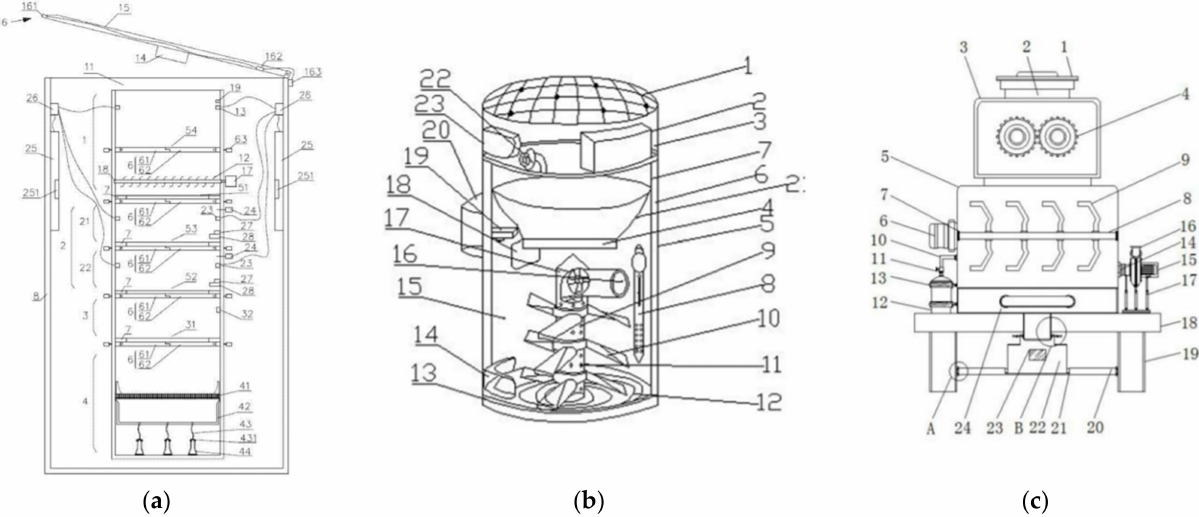
Figure 21. ( a ) An aerobic fully automated composter from CN208649153U [101], with details